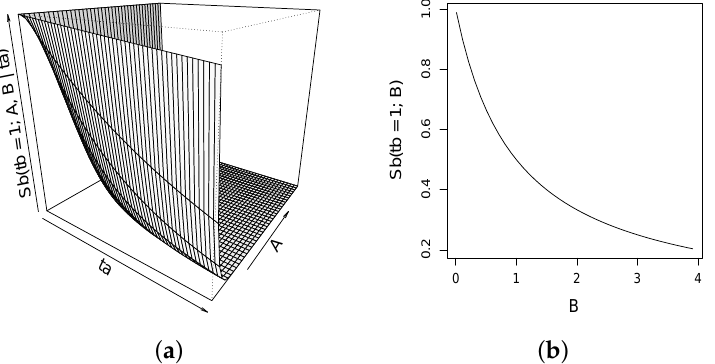
Figure 2. ( a .) The survivor function for T b in Proposition 1(c). S b ( t b = 1; B = 2, A | t a ) decreases with increase in t a and A . ( b .) The marginal survivor function for T b in Proposition 1(c). S b ( t b = 1; B ) decreases with B